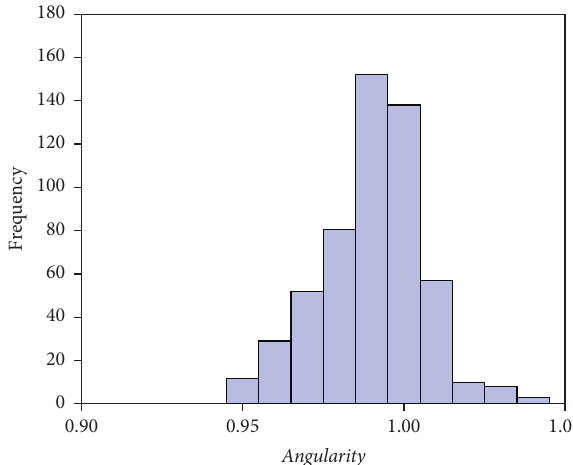
Figure 10: Statistical results of the length flatness index calculated by the rotation